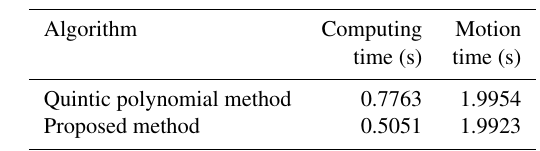
Table 1. Comparison of computing and motion